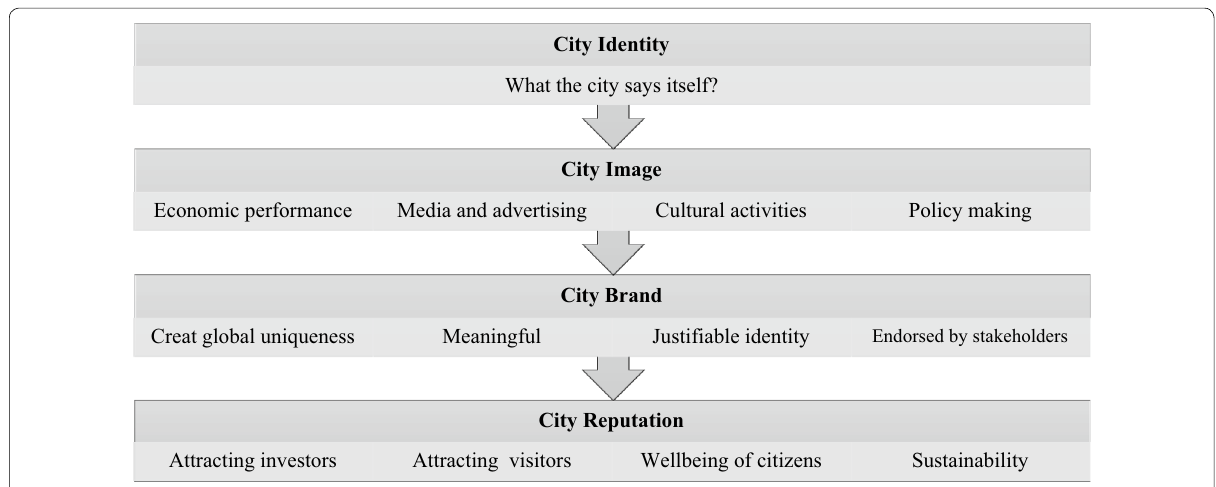
Fig. 1 The process of strengthening the city’s reputation in the globalisation